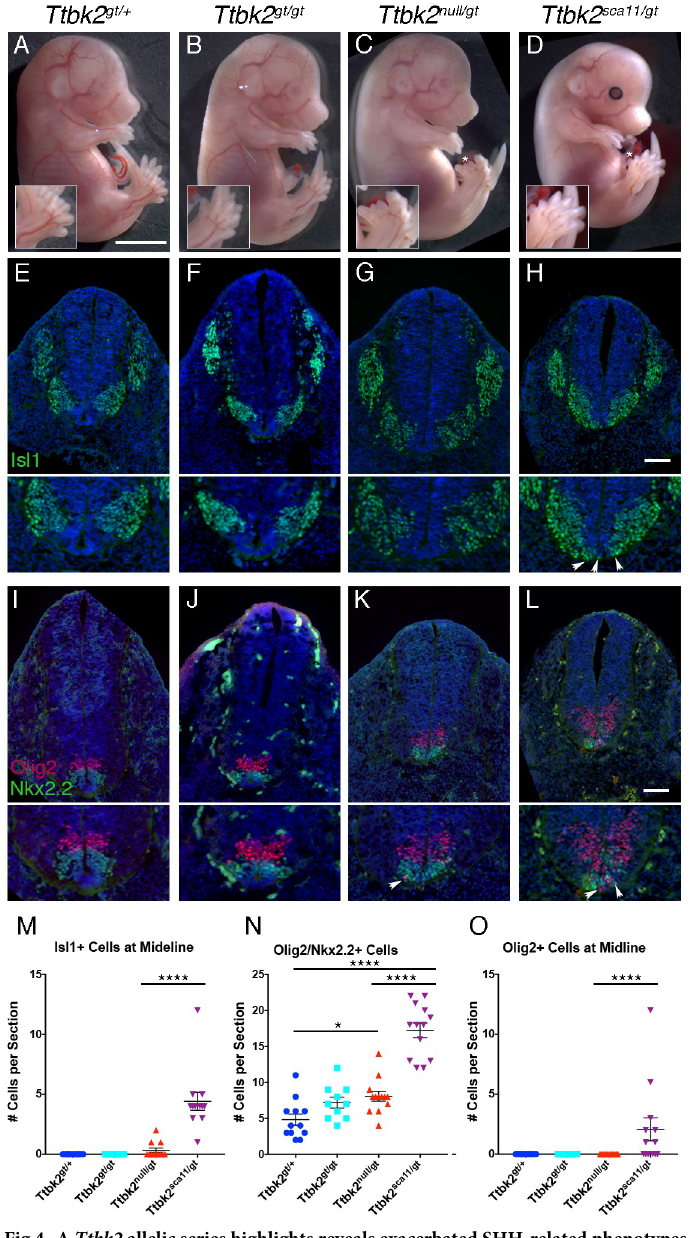
Fig 4. A Ttbk2 allelic series highlights reveals exacerbated SHH-related phenotypes in Ttbk2 sca11/gt embryos. (A-D) Representative E15.5 embryos of each of the indicated Ttbk2 allelic combinations. Scale bar = 3mm. � Denotes duplicated digits. Insets are 1.5X enlargements of the hindlimbs shown in each image. (E-H) Transverse sections through the neural tube of E10.5 embryos of the indicated genotypes. Sections were taken at the forelimb level and immunostained for the motor neuron marker ISL1. Scale bar = 100 μ m. Images below are 1.5X enlargements of the ventral portion of each neural tube section. Arrowheads in H denote ventrally displaced motor neurons spanning the ventral midline. (I-L) Representative transverse sections through E10.5 neural tubes of embryos of each indicated genotype immunostained for NKX2.2 (green) to label V3 interneuron progenitors and OLIG2 (red) to label motor neuron progenitors. Scale bar = 100 μ m. Images below are 1.5X enlargements of the ventral portion of each neural tube section. Arrows in K and L denote ventrally displaced OLIG2+ progenitors. (M) Quantification of the number of ISL1 + cells seen at the ventral midline per section. Sections were taken at the forelimb level as pictured in E-H. 3 sections in 4 different embryos were for each genotype except for Ttbk2 gt/gt in which 3 embryos were evaluated. Each point represents the count for one section. ISL1+ cells were never observed at the midline for Ttbk2 gt/+ or Ttbk2 gt/gt . By contrast, in Ttbk2 null/gt , 3 out of 4 embryos evaluated had a small number of cells at the midline in at least 1 section, and in Ttbk2 sca11/gt embryos, ISL1+ cells were counted at the midline in all sections of all embryos. The number of